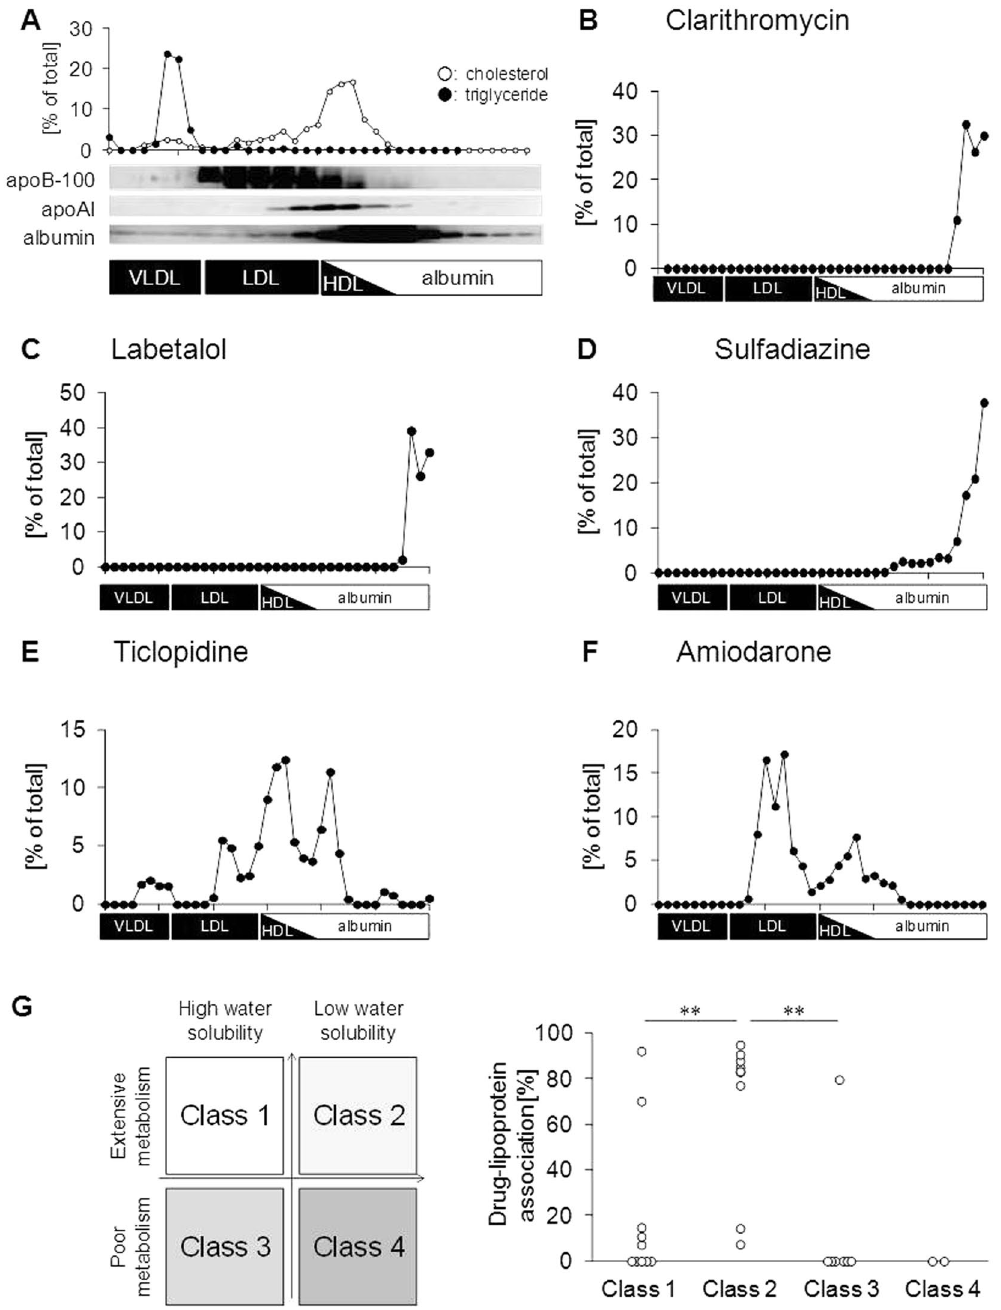
Figure 1. Association of various drugs with lipoproteins. ( A ) Serum lipoprotein fractions from wild-type mice obtained 2 h after oral drug administration were identified according to the concentrations of cholesterol and triglycerides, and the presence of apoB-100, apoAI, and albumin. The total amount of cholesterol and triglycerides in the fractions was considered to be 100%. ( B–F ) In vivo analysis of drug association with lipoproteins. ( B ) Clarithromycin; (C ) labetalol; ( D ) sulfadiazine; ( E ) ticlopidine; and ( F ) amiodarone. ( G ) The left panel shows the BDDCS classification of drugs into four types. The right panel shows the extent of drug- lipoprotein association according to BDDCS. ** p <